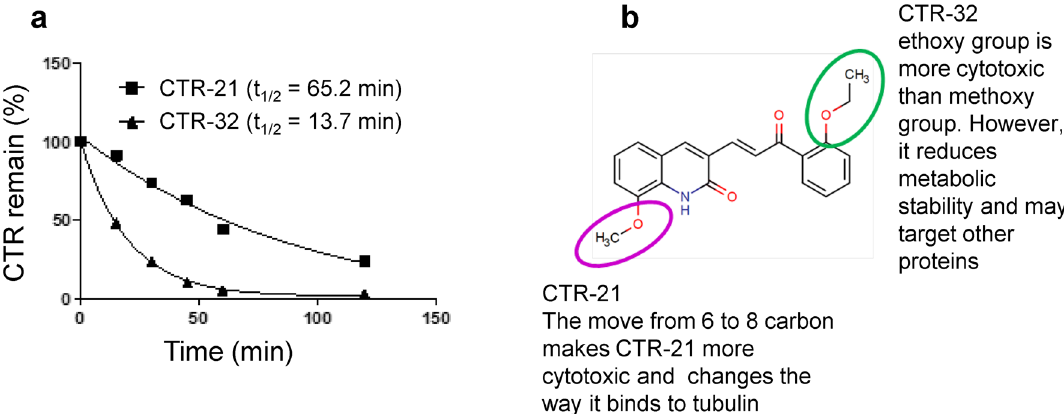
Figure 4. CTR-21 is the most active and stable one among this series. ( a ) CTR-21 is much more metabolically stable than CTR-32. 5 µM of CTR-21 or CTR-32 were incubated with human microsomes (20 mg/ml protein) in the presence of NADPH over the course of 120 min. The lysates were analyzed and % remaining CTR compounds were identified and estimated using HPLC–MS. ( b ) Summary of structure–activity relationship (SAR) based on activity and metabolic